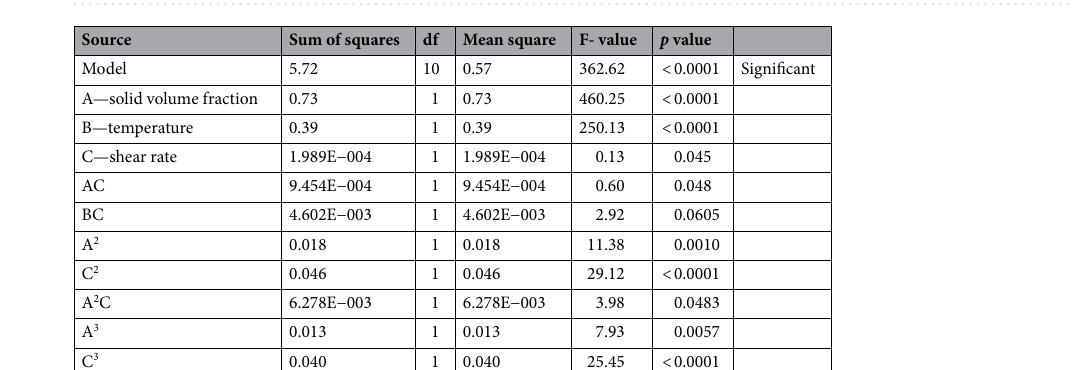
Figure 9. Margin of deviation.